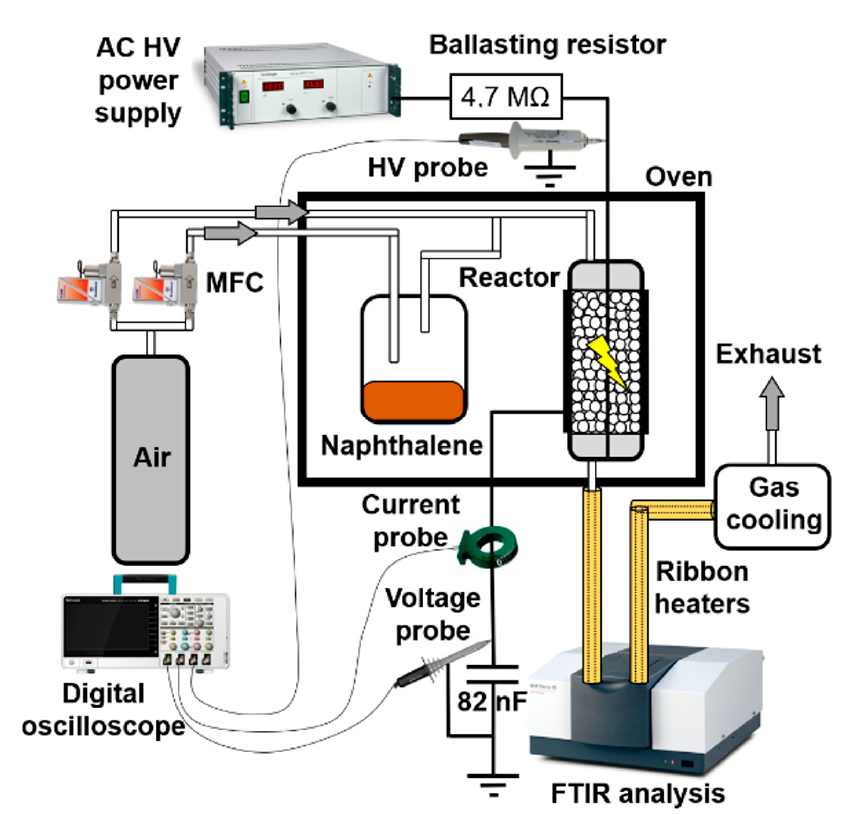
Figure 8. Experimental